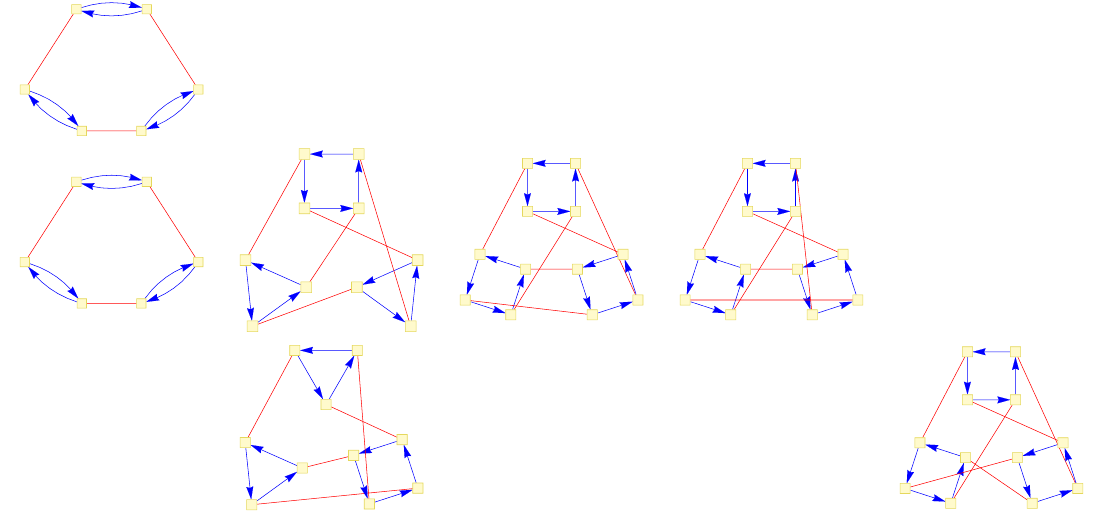
Figure 13 . Skeleton graphs of ( G 3 ) connected (4 ; 4 ; 4). The top, middle and bottom row corresponds to (cid:24) = 0 ; 1 ; 2, respectively.